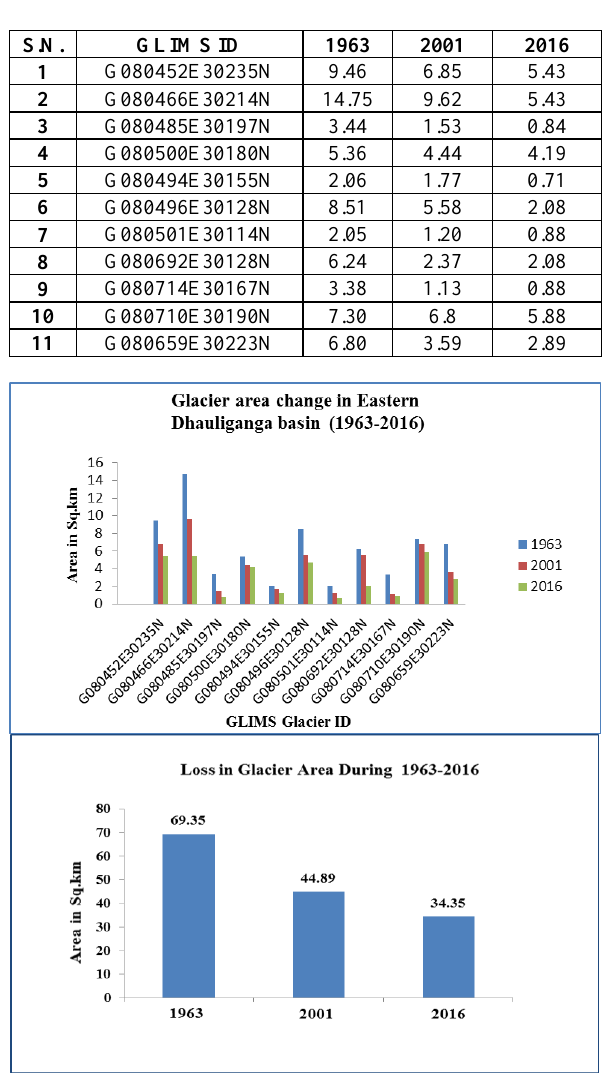
4. RESULTS Figure 6&7. Observed Change in glaciers of Eastern Dhauliganga basin Glaciers of the upstream side are receding slowly as compared to the downstream region. In the downstream region, glaciers are showing fast dynamics. Their frontal part is vacating more to the glaciers of an upward region. The total glacier area in 1963 was 69.35 Sq.km, 44.89 sq.km in 2001 and 34.35 in 2016. A loss in the glaciated area reduced to 35.29 Sq.km. from 1963- 2016. The loss may be occurred due to human accessibility and changes in the meteorological phenomenon.